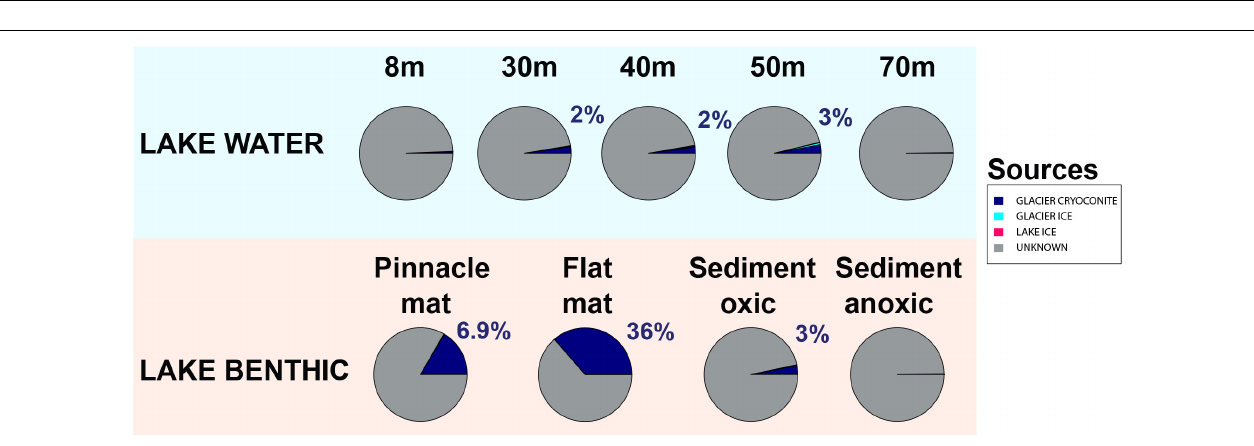
FIGURE 10 | Archaeal beta diversity at Lake Untersee Oasis. Habitats are color-coded and further description is depicted as text: CRY, Cryoconite holes; WIP, White ice patch. For a better visualization, an axis break on the x -axis was introduced.